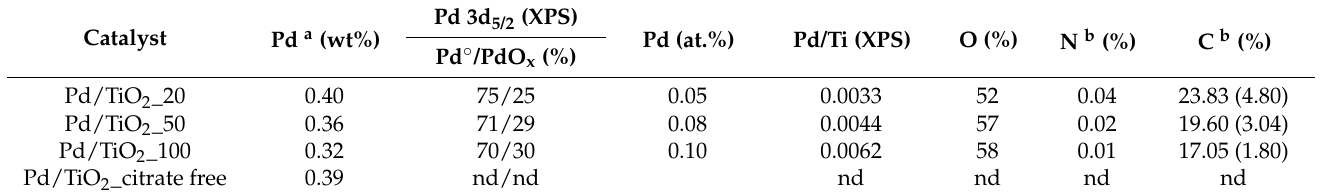
Table 1. Pd loading (ICP-AES) and XPS results for the Pd/TiO 2 _x (x = 20, 50, 100) and Pd/TiO 2 _citrate free